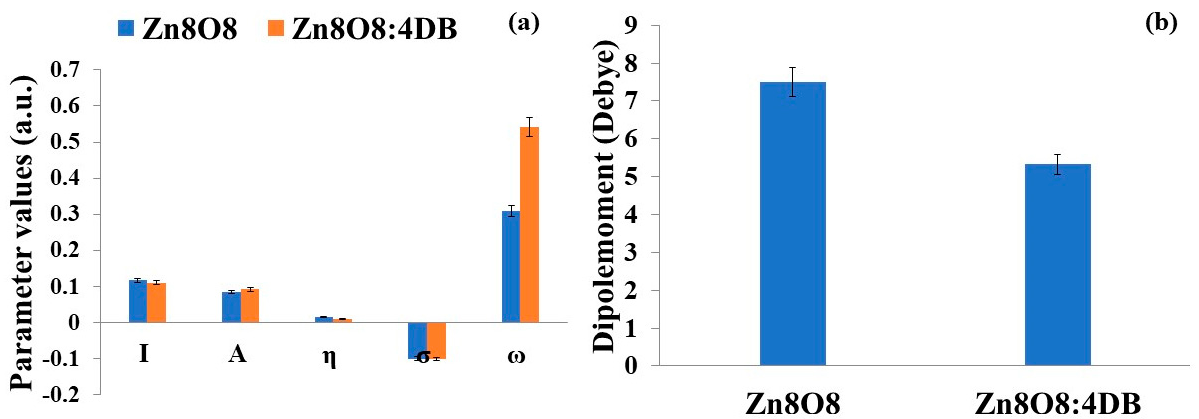
Figure 7. ( a ) Molecular properties (in a.u.) of the Zn8O8 and Zn8O8:4DB clusters and ( b ) dipole moments (in Debye) of the Zn8O8 and Zn8O8:4DB clusters.